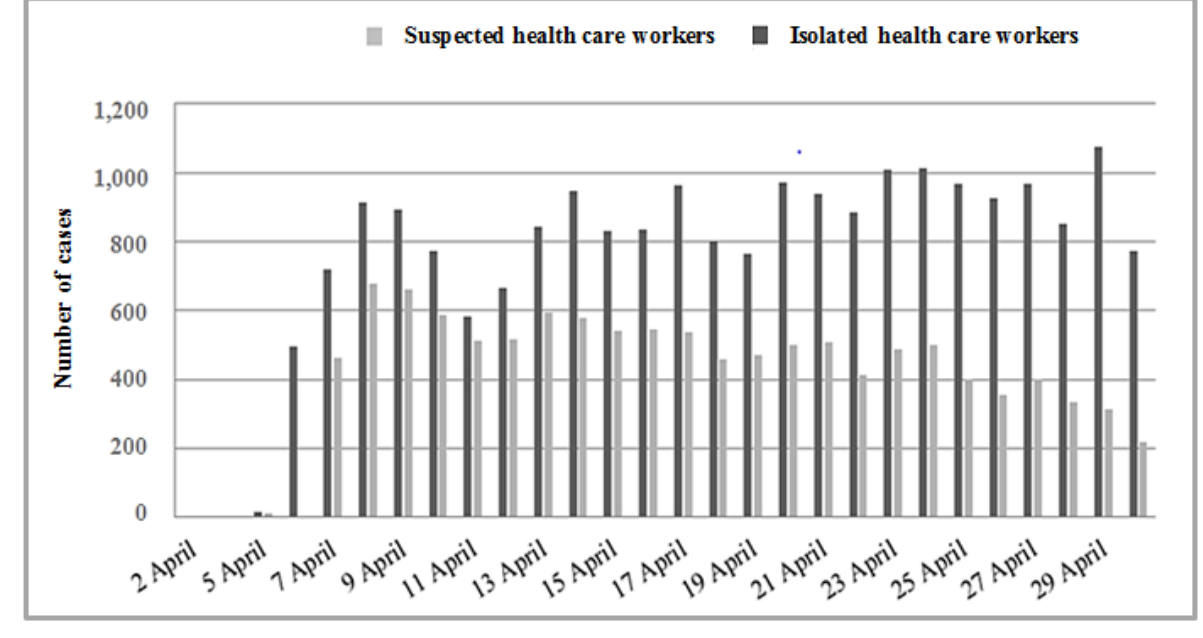
Figure 4. Number of suspected cases in health care workers and number of isolated health care workers, as reported by LTCF healthcare staff over 30